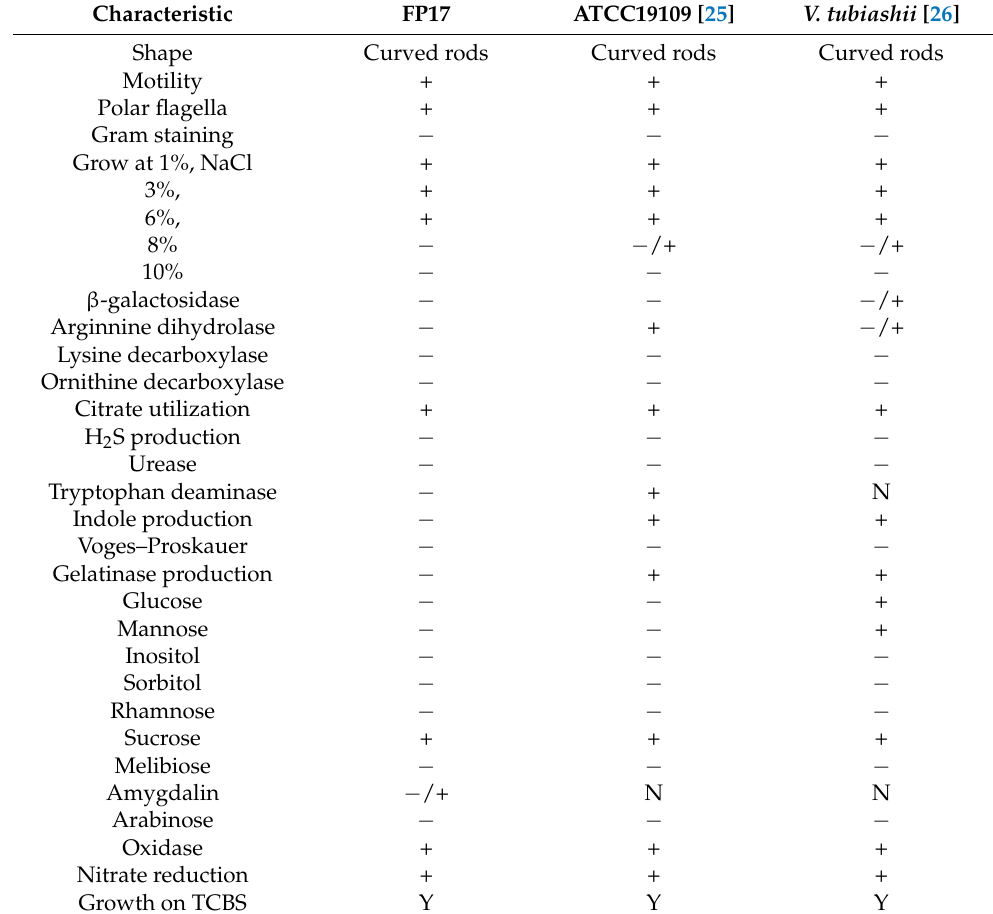
Table 1. Phenotypic characteristics of the Vibro tubiashii FP17.